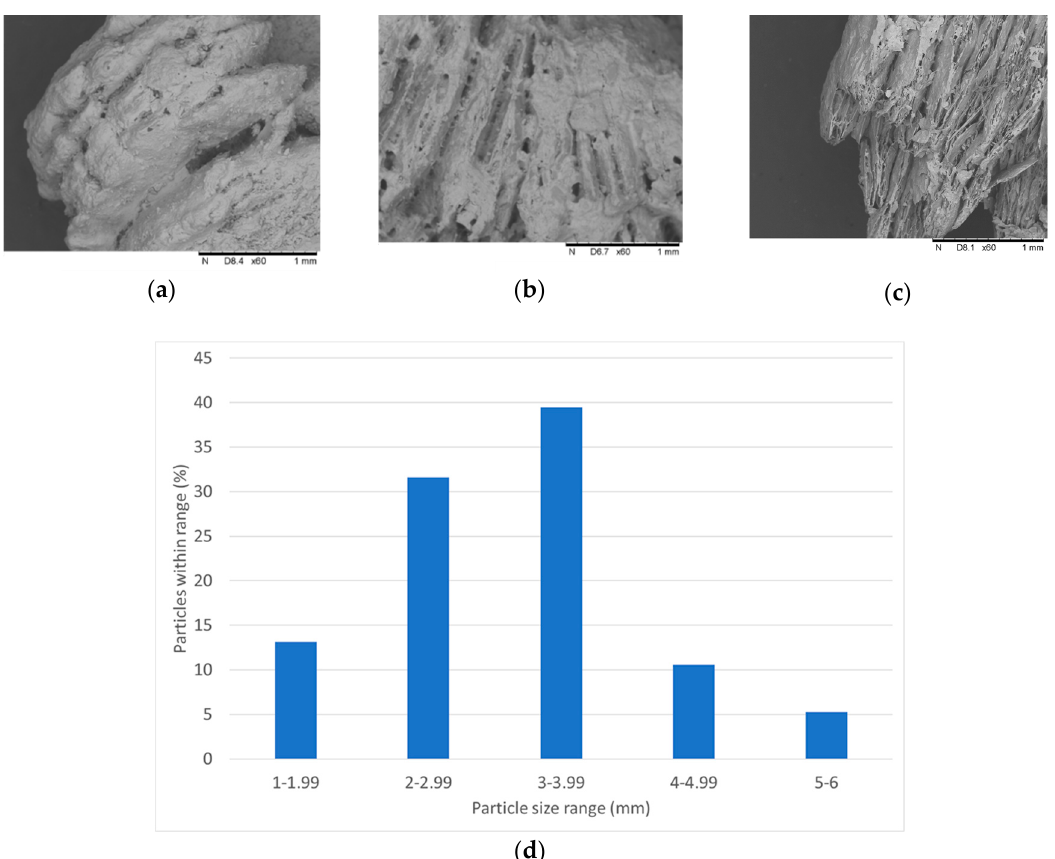
Figure 1. SEM of the salt in matrix (SIM) material at ( a ) 3:1, ( b ) 2:1 and ( c ) 1:1 salt to vermiculite ratios and ( d ) the particle size distribution of the SIM at 2:1 salt to vermiculite ratio.